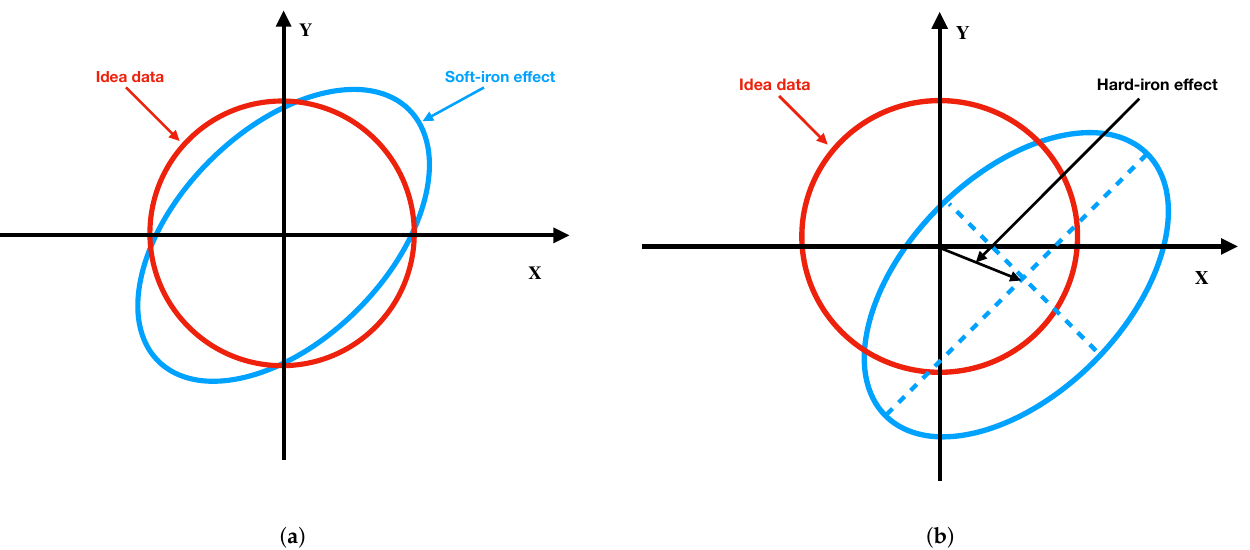
Figure 1. Soft and hard iron effects: ( a ) soft iron effect; ( b ) hard iron